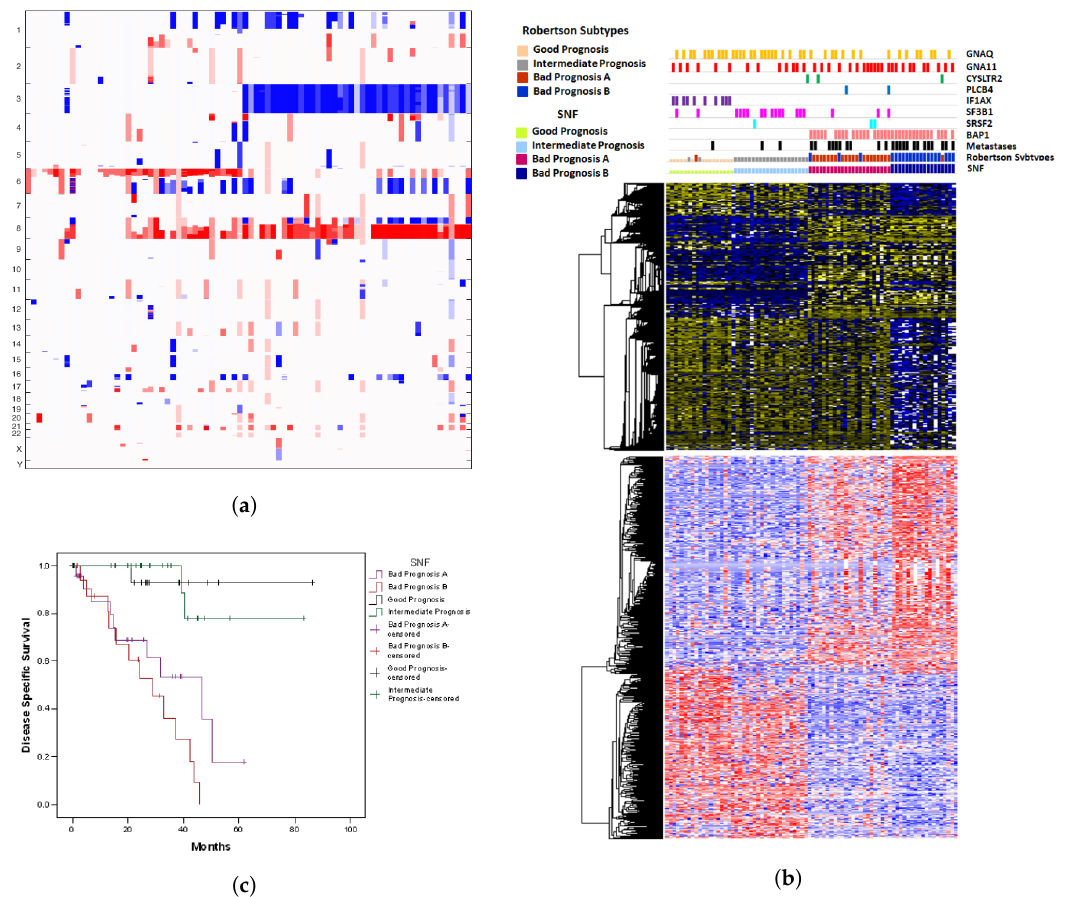
Figure 3. ( a ) Copy Number variation plot for the clusterings obtained by SNF; columns = samples, rows = chromosomes. ( b ) Somatic mutation, transcriptome and methylome data for the clusterings obtained by SNF; columns = samples, rows = genes. ( c ) Kaplan Meyer survival curves for the clusterings obtained by SNF; y -axis = ratio of patients surviving, x -axis: time in